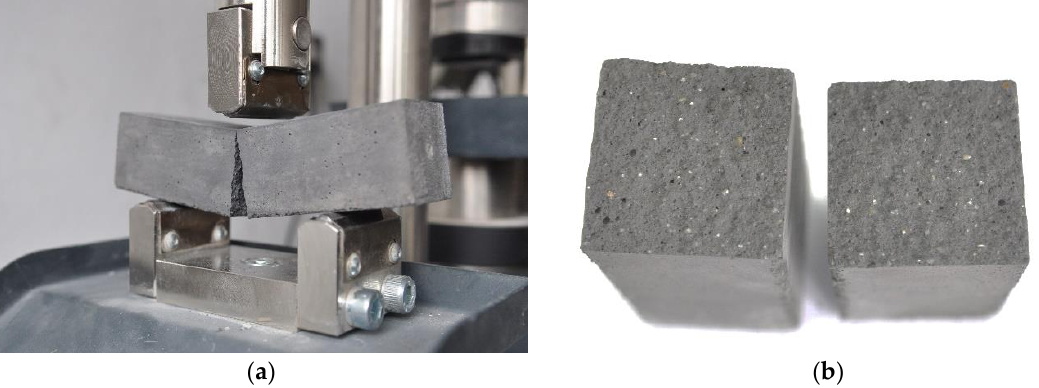
Figure 3. Mode of failure of the beam specimen: ( a ) flexural crack; ( b ) fracture view of the cracked sample.